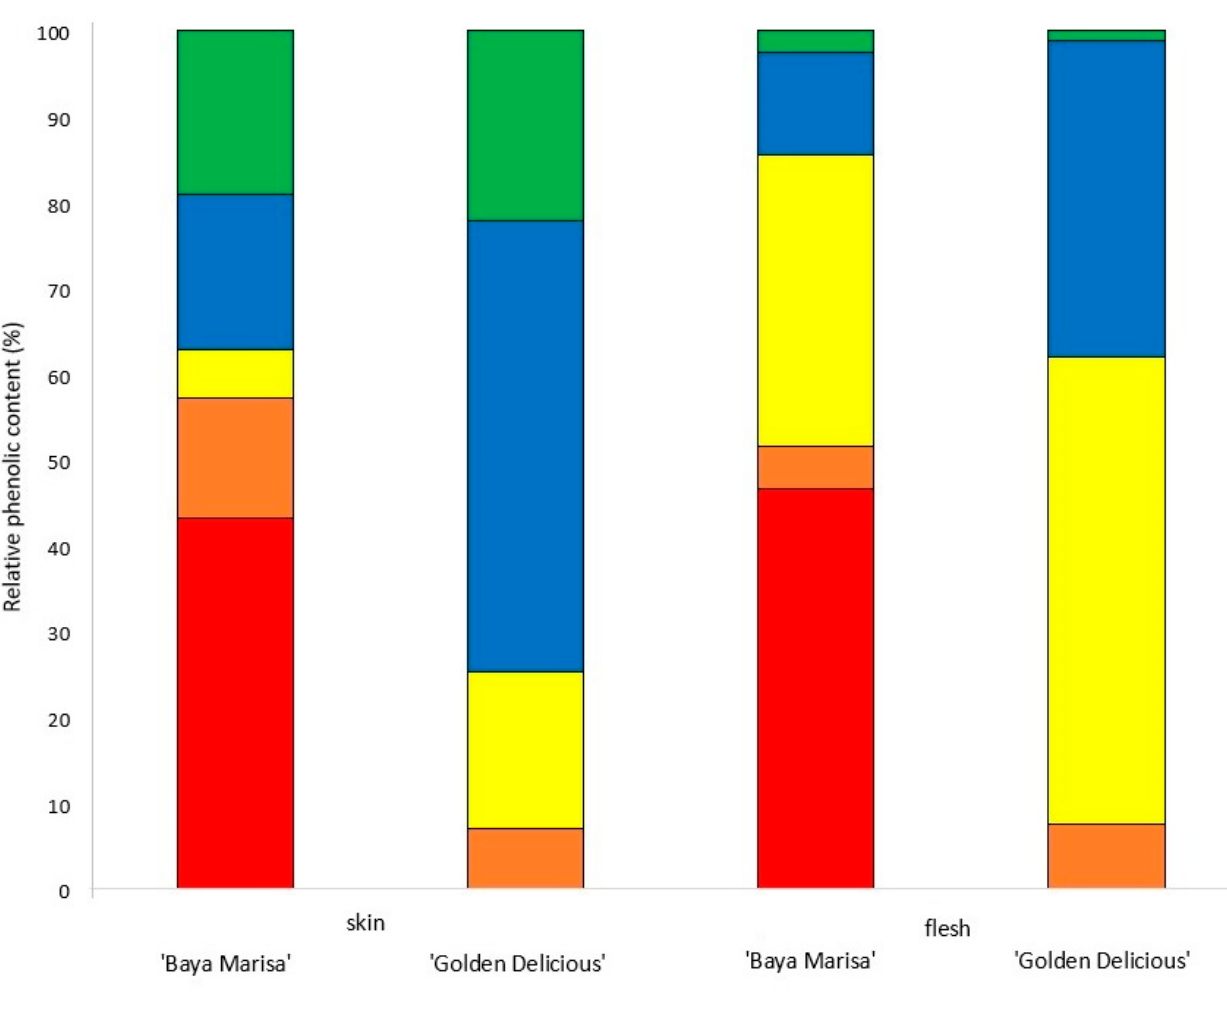
Figure 2. Relative content of identified phenolic compounds in apple ( Malus domestica Borkh.) cul- tivars ‘Baya Marisa’ and ‘Golden